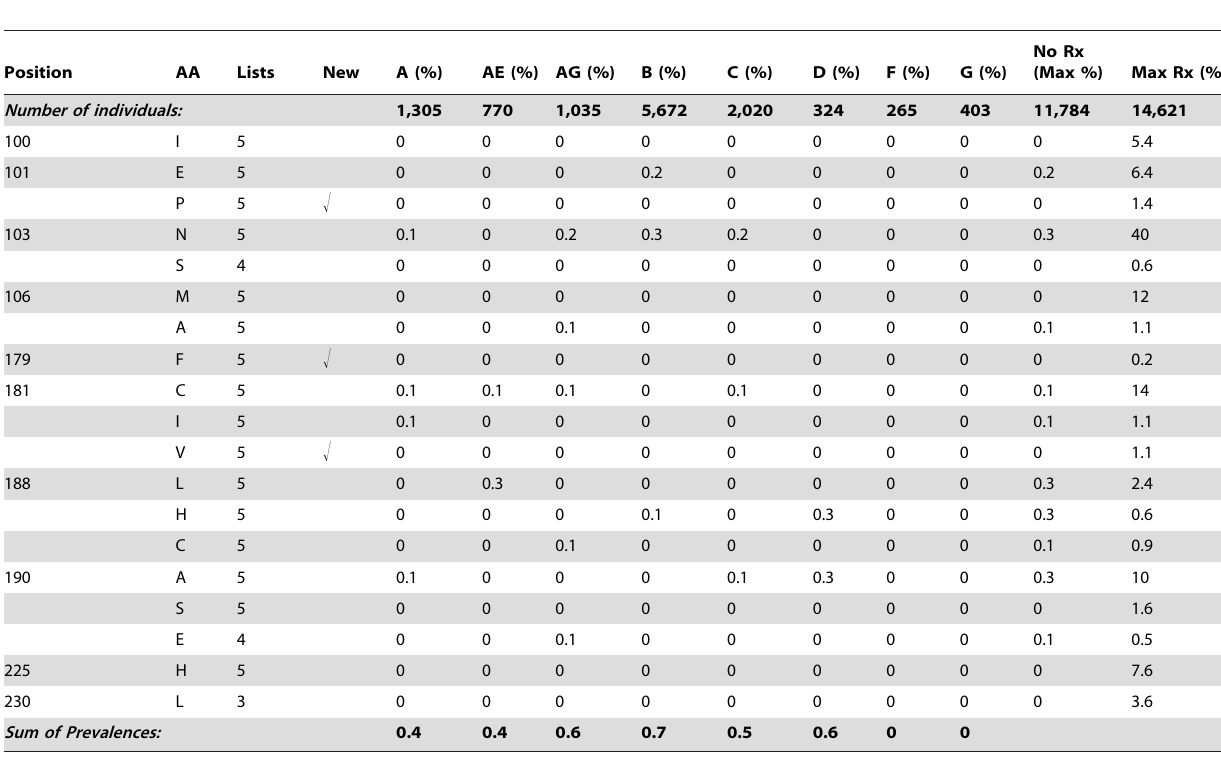
Table 3. Non-Nucleoside RT Inhibitor Surveillance Drug Resistance Mutation (SDRM) List: 19 Mutations at 10 Positions